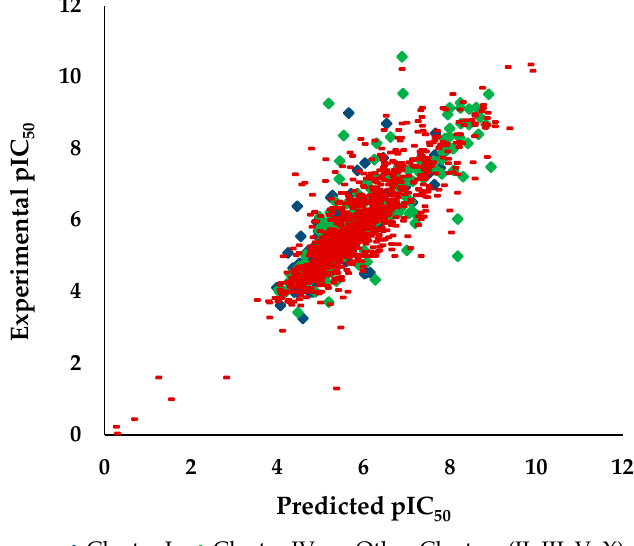
Figure 3. Predicted vs. experimental pIC 50 against HCT116 for the 129, 200 and 1135 molecular structures of I, IV and others clusters of the test set, respectively.